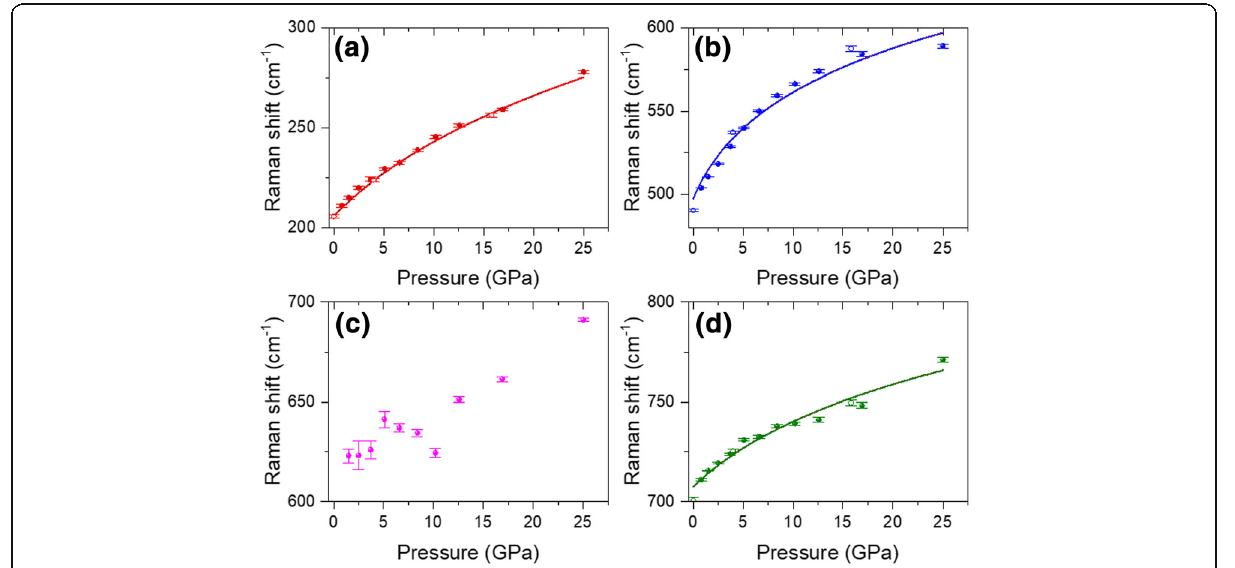
Fig. 4 Raman shifts of different phonon modes as a function of different compressive pressures (solid sphere) and decompressive pressures (opened circles): a 210 cm − 1 , b 504 cm − 1 , c 620 cm − 1 , and d 711 cm − 1 . Solid lines are the fitting results using the equation ω ð P Þ = ω 0 ¼ ½ð δ 0 = δ 0 Þ P þ 1 (cid:2) δ